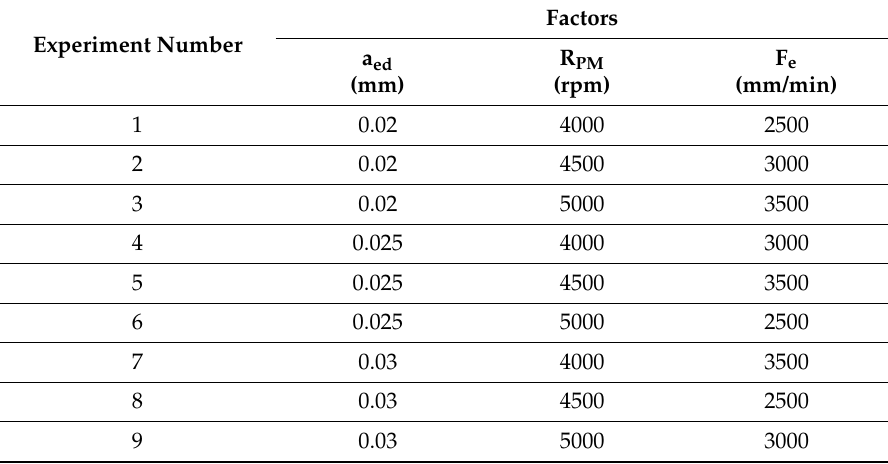
Table 3. Standard L9 (3 3 ) orthogonal matrix.